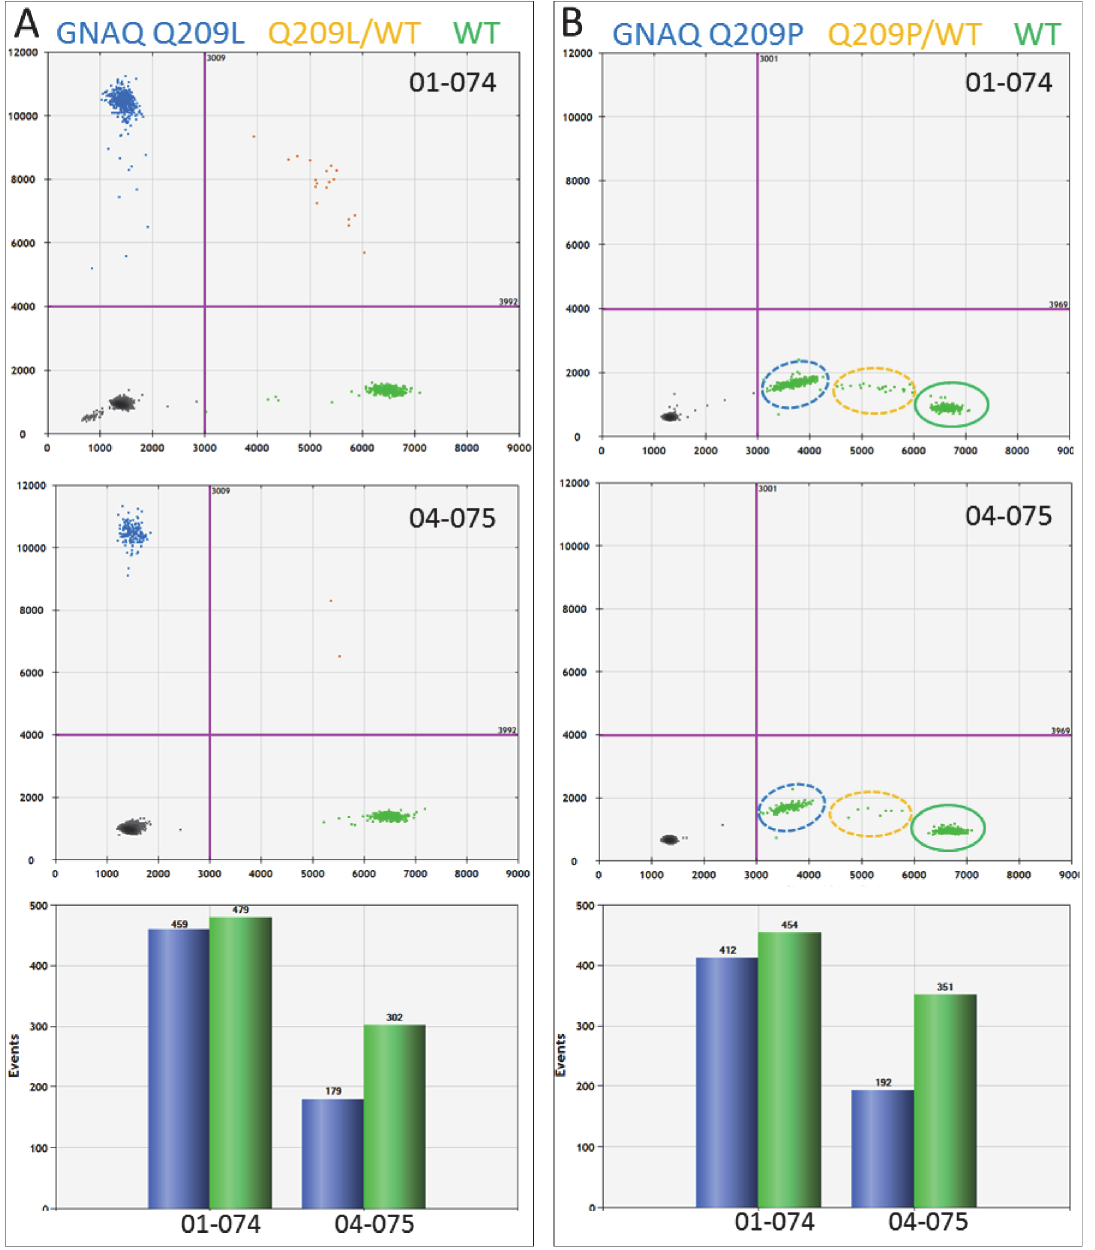
Fig 1. GNAQ mutation detection in UM by dPCR. Two color digital PCR is presented as a 2D plot. On the x-axis, the number of WT amplicons (green) is indicated and on the y-axis the mutant amplicons (blue) are counted. Empty PCRs and negative amplicons (black) end up in the bottom left quadrant. (A) PCRs containing WT and mutant (orange) will end up in the upper right quadrant. Based on Poisson distribution, the number of WT and mutant amplicons can be calculated (bar graph). This shows that 01 – 074 represent a homogeneous and 04 – 075 a heterogeneous UM sample. (B) Digital PCR analysis of these samples with the GNAQ Q209P assay did not result in mutant signals but aberrant signals on the x-axis. Manual selection of the aberrant signals in the WT quadrant of the plot learned that the clusters matched the positive clusters in the GNAQ Q209L assay. This indicates that the WT probe hybridized with low efficiency to the GNAQ Q209L allele in UM 01 – 074 and UM 04 – 075 in the absence of specific probe.